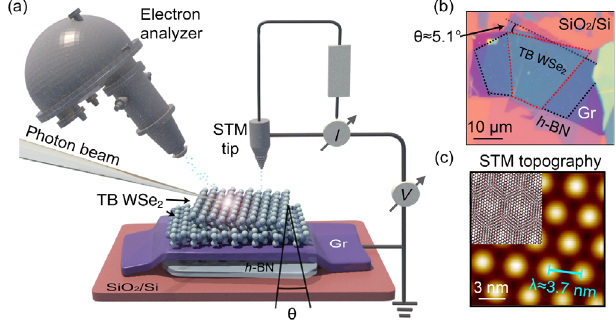
FIG. 1. Device design and experiment layout. (a) Schematic illustration of the device design and the experiment layout. From bottom to top, the red, light blue, and purple sheets stand for SiO 2 = Si, h -BN, and graphite substrates, respectively, and the atomic model stands for a bilayer WSe 2 with a twist angle ( θ ). For ARPES measurements, photoelectrons are collected by a hemi- sphere analyzer; for STM measurements, tunneling electrons are tuned by the current ( I ) and voltage ( V ) sources and collected by the STM tip. (b) Optical image of 5.1° TB WSe 2 device. Dashed lines of red and black mark boundaries of top and bottom layer WSe 2 , respectively. SiO 2 = Si, h -BN, and graphite substrates appear in the same colors as shown in the illustration. The included angle of upper boundaries of top and bottom layers is the twist angle, θ ≈ 5 . 1 °. (c) STM topography, acquired at fixed ¼ − 1 . 39 V and current I ¼ 90 pA, showing bias voltage V bias the moir´e pattern with a periodicity of λ ≈ 3 . 7 nm. The inset presents the atomic structure of TB WSe 2 lattice constant of WSe 2 was measured as a ¼ 0 . 33 nm (see SM for more details [24]).